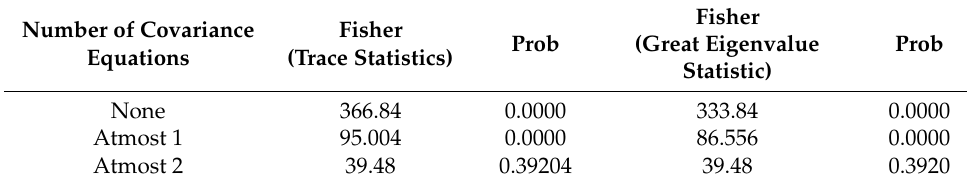
Table 3. Table of panel data from the co-integration